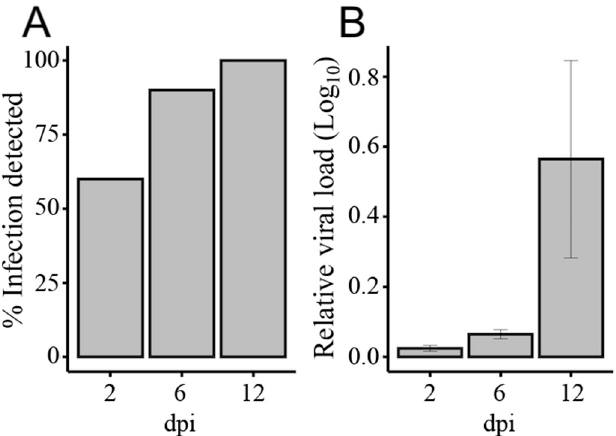
Figure 1. Measurement of Ross River virus (RRV) infection in Aedes aegypti mosquitoes at 2, 6, and 12 days post-infection (dpi) by RT-qPCR. ( A ) Rate of infection: percentage of mosquitoes with a detectable degree of RRV infection ( N = 10), and ( B ) their relative viral load ( N = 6). Error bars indicate the standard error of the mean of normalized expression values. The Ae. aegypti ribosomal protein subunit 17, RPS17 , gene was used as the internal calibrator.